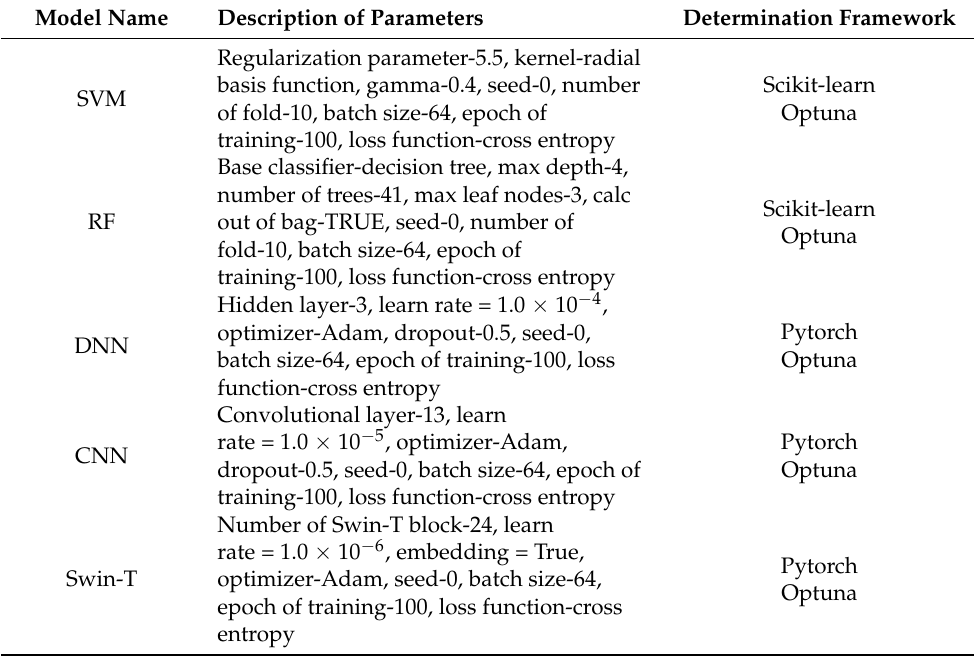
Table 2. Hyper-parameters of models used in this